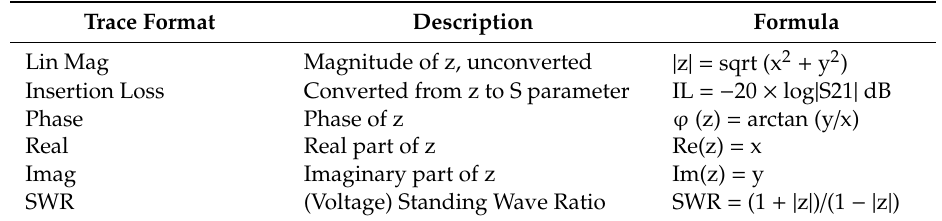
Table 3. The formula used for extracting values in the different Cartesian diagrams from the complex measurement .